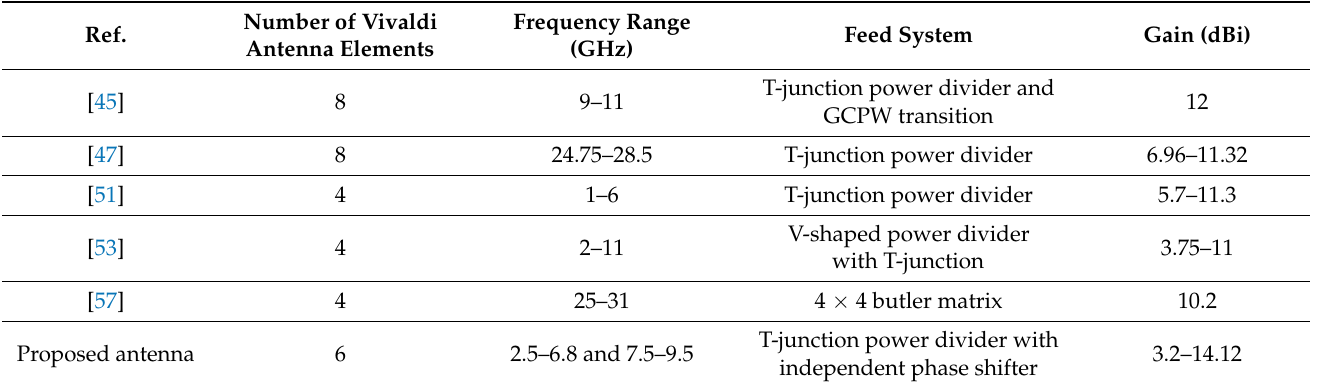
Figure 7. The measured variation of beam components with frequency: ( a ) front-to-back ratio and beam width; ( b ) E-plane beam tilts.